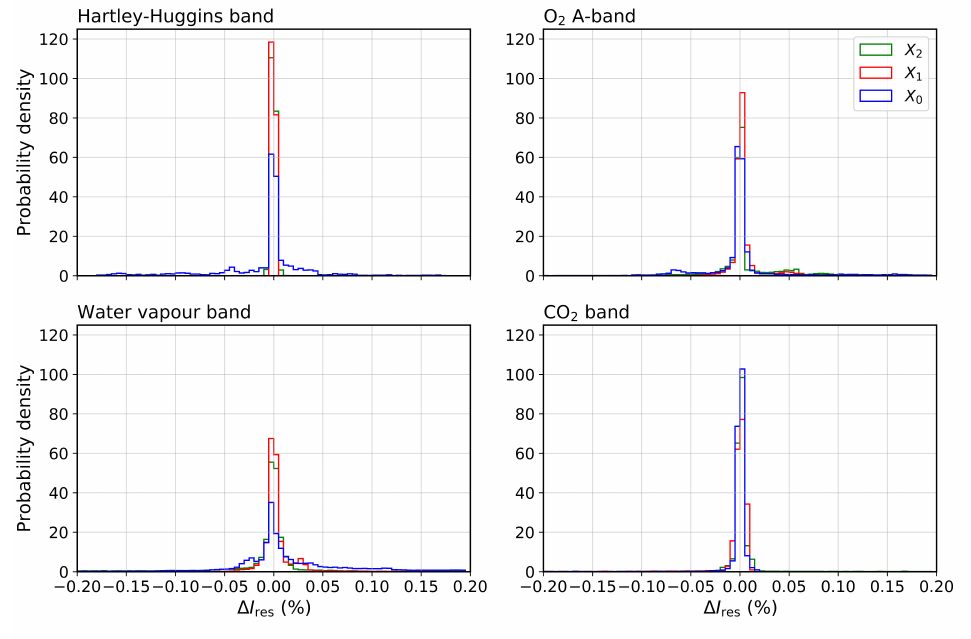
Figure 8. Same as Figure 7, but for the double CLSR